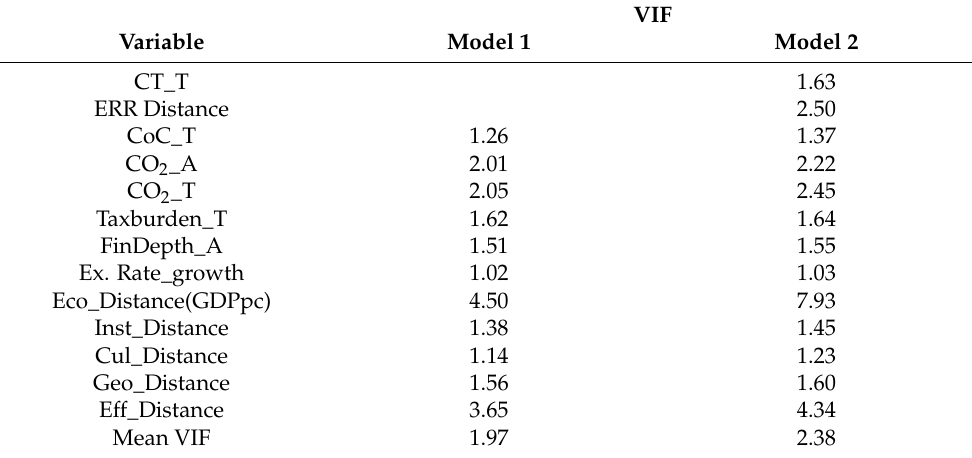
Table 3. VIF values for checking multicollinearity among the variables in all the